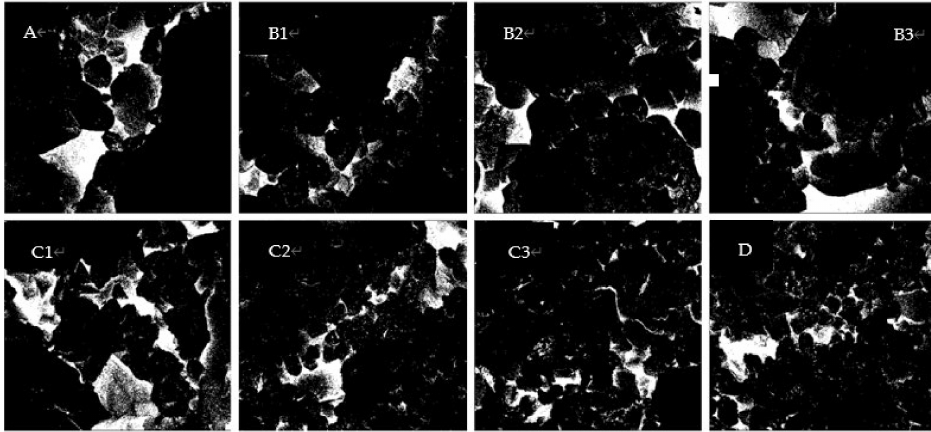
Figure 6. SEM images of sand solidified with various nutrient solution compositions. SEM image of group A ( A ); SEM image of group B1 ( B1 ); SEM image of group B2 ( B2 ); SEM image of group B3 ( B3 ); SEM image of group C1 ( C1 ); SEM image of group C2 ( C2 ); SEM image of group C3 ( C3 ); SEM image of group D ( D